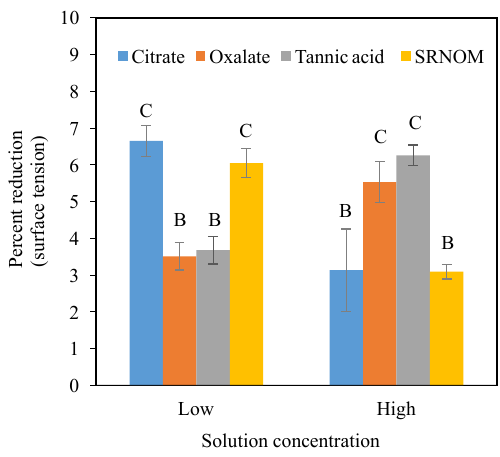
Figure 8. Percent reduction in surface tension from the control (NaCl + HNS) (group A), changes at stable time (90s), for plant exudates (citrate and oxalate), and soil components (tannic acid and organics: Suwanee River natural organic matter, SRNOM), and sta- tistical analysis for t -test significant differentiations. Note: averages graphed and associated error bars represent 1 standard deviation, and values not connected by same letter are significantly